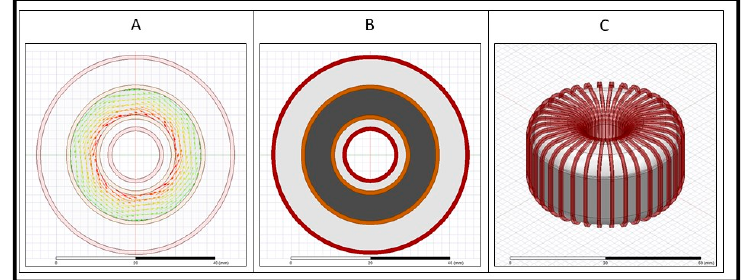
Figure 8. The 360° modified ( A ) 2D model; ( B ) flux distribution; ( C ) 3D model.